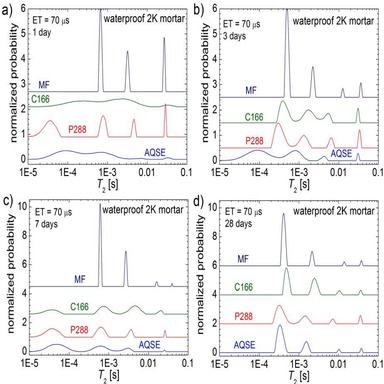
The normalized distribution of T2 measured at a) 1 day, b) 3 days, c) 7 days and d) 28 days after preparation for samples of waterproof 2 K mortars.